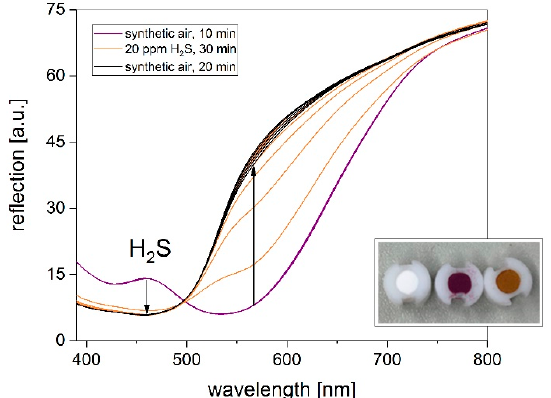
Figure 2. Reflection spectra of the powder sample exposed to 20 ppm H 2 S in synthetic air and a relative humidity of 40% at room temperature. Recording of 15 measurement cycles at intervals of 4 min.